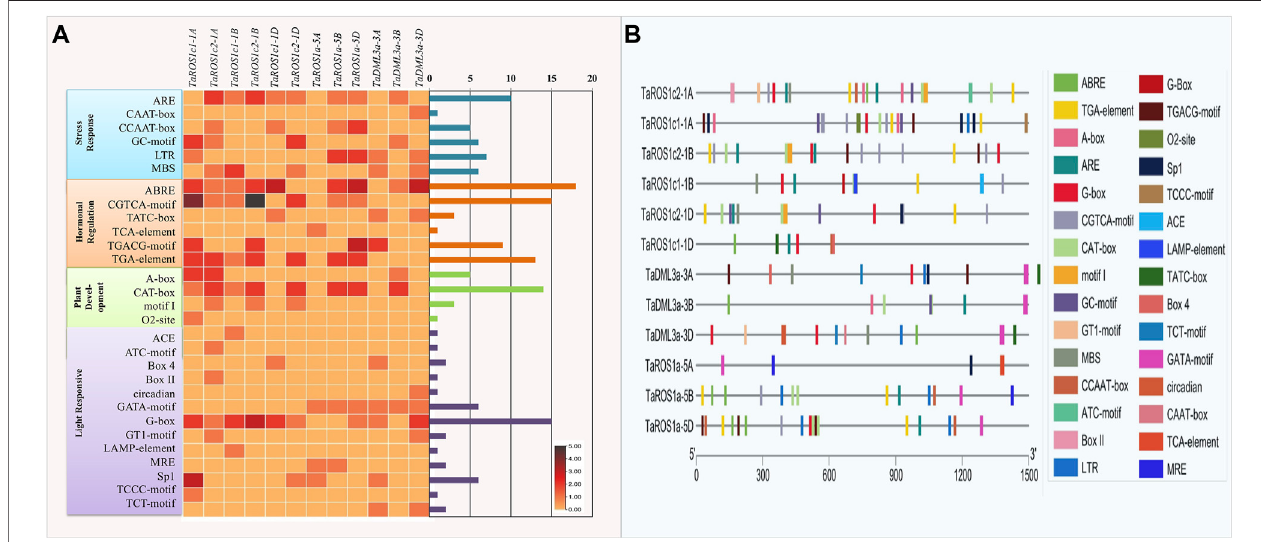
FIGURE 4 | Cis-regulatory elements (CREs) of wheat dMTases genes. (A) Showing the number of CREs belonging to the following four categories (stress- responsive, hormonal regulation, plant development, and light-responsive) per dMTase gene asa heatmap.The bar plots on the right represent the number ofCREs for each dMTase gene. (B) The distribution of different CREs in the promoter region (1,500 base pairs) of wheat dMTase genes. Different CREs are represented by distinct colors as